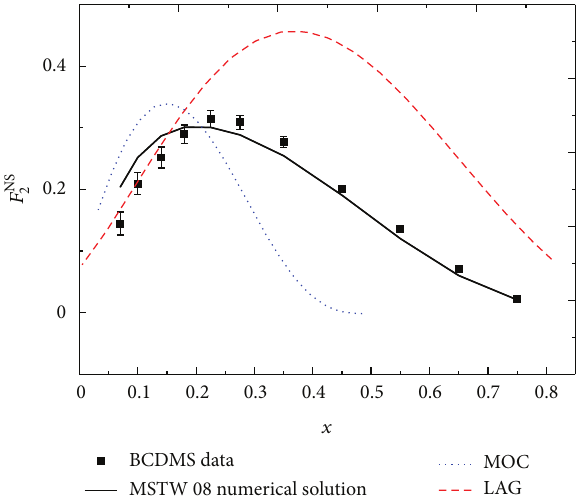
Figure 5: Nonsinglet structure function 𝐹 NS 2 (𝑥,𝑄 2 ) as a function of 𝑥 at different 𝑄 2 values according to (19) and (45). Data from [24].